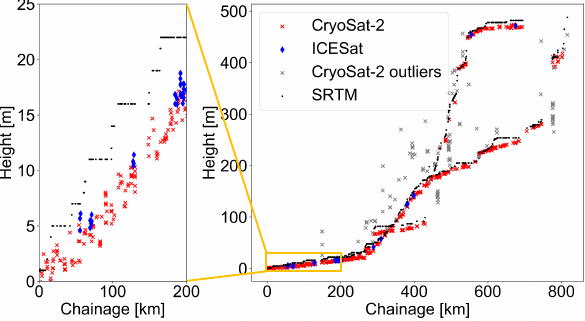
Figure 3. Longitudinal profile of the single CryoSat-2 observations, transect-averaged ICESat observations and corrected SRTM refer- ence heights on the Ogooué and its tributaries.